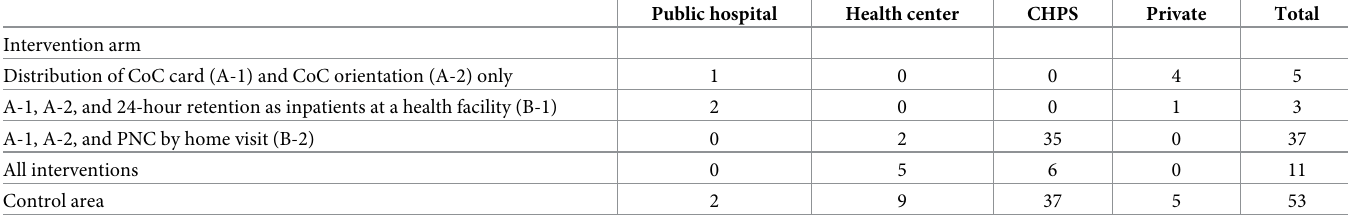
Table 1. Number of health facilities by type and content of